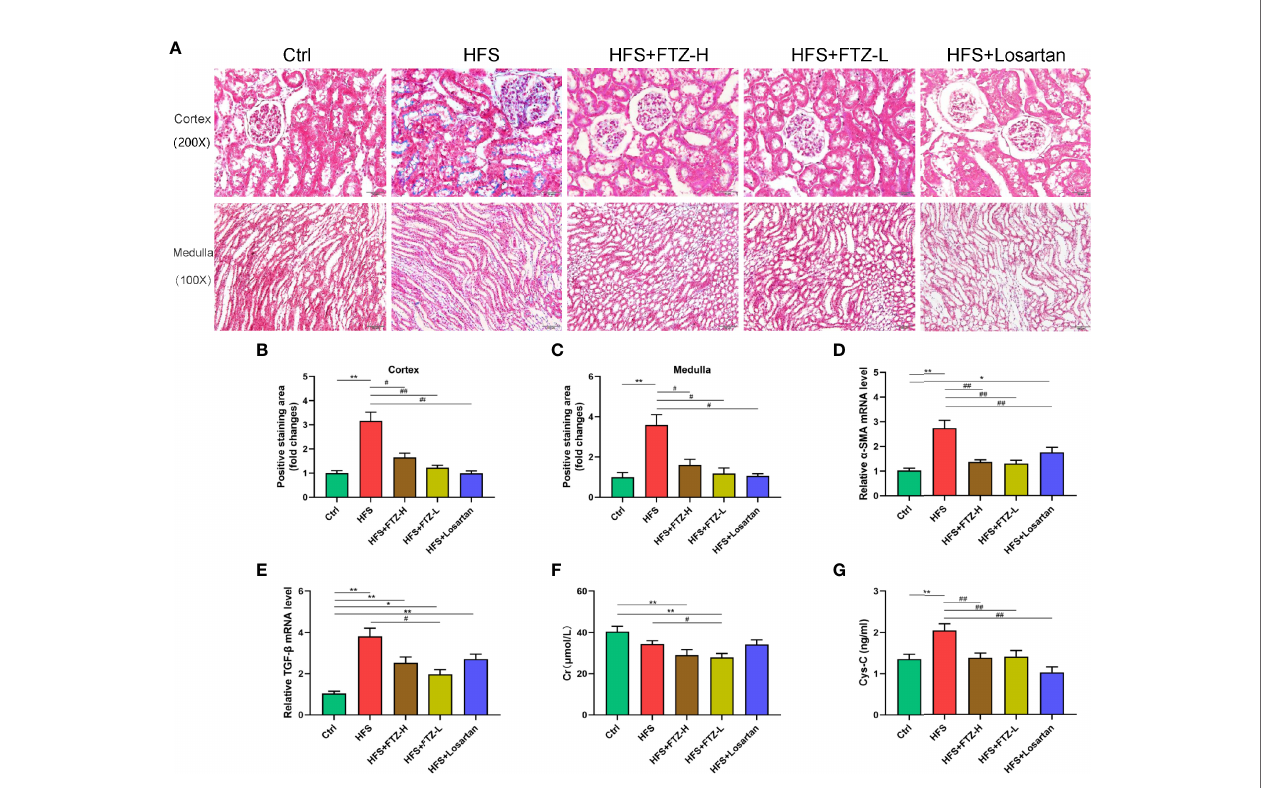
FIGURE 2 | FTZ reduced renal fi brosis and improved renal function in HFS-fed rats. (A) Masson staining of kidney sections. (B) Positive staining area in renal cortex. (C) Positive staining area in renal medulla. (D, E) Relative mRNA expression of a -SMA and TGF- b in renal cortex. (F, G) Serum Cr and Cys-C. ∗ p < 0.05, ∗∗ p < 0.01 vs. Ctrl; # p < 0.05, ## p < 0.01 vs. HFS. n = 8 per group. FTZ, Fufang-Zhenzhu-Tiaozhi capsule; HFS, high fructose and high salt; Cr, creatinine; Cys-C, cystatin